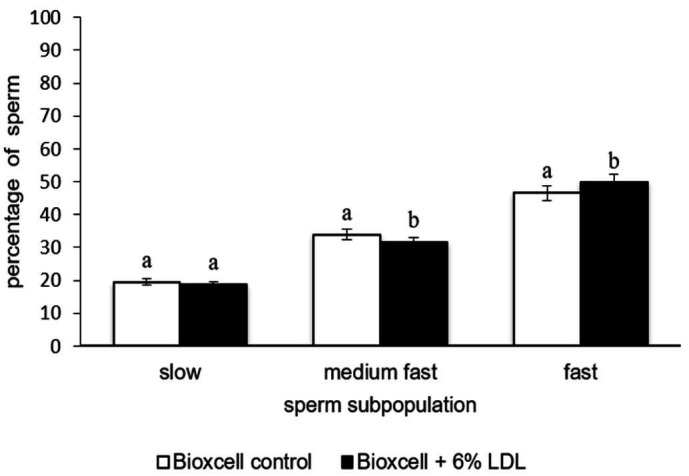
Effect of LDL in Bioxcell extender on sperm distribution in clusters after thawing. Different superscripts in same cluster represent significant differences (P < 0.05).